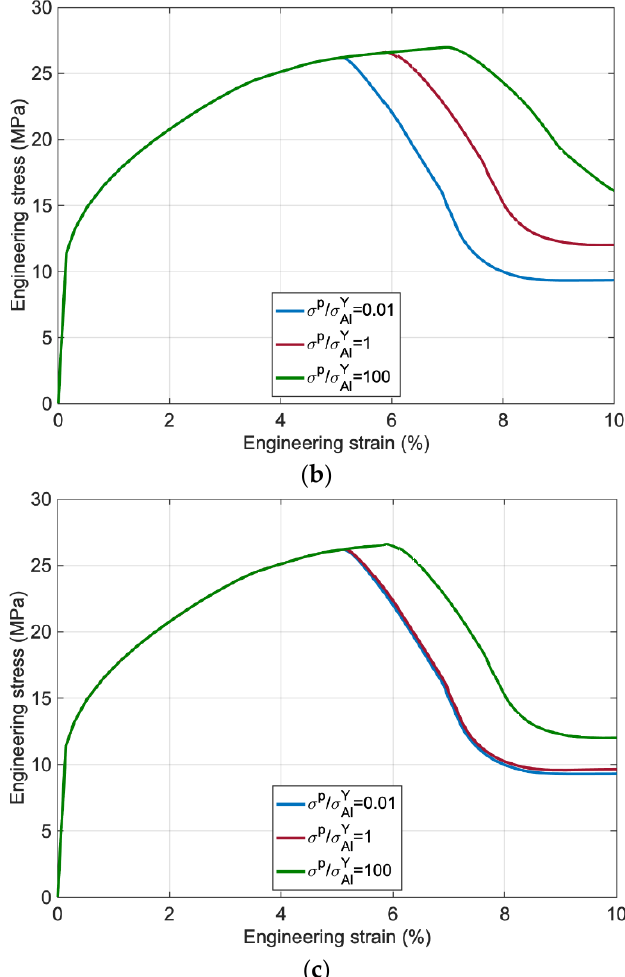
Figure 9. Engineering stress versus engineering strain for ( a ) 𝛿 (cid:3043) /ℎ = 0.01 , ( b ) 𝛿 (cid:3043) /ℎ = 1 and ( c ) 𝛿 (cid:3043) /ℎ = 100 .